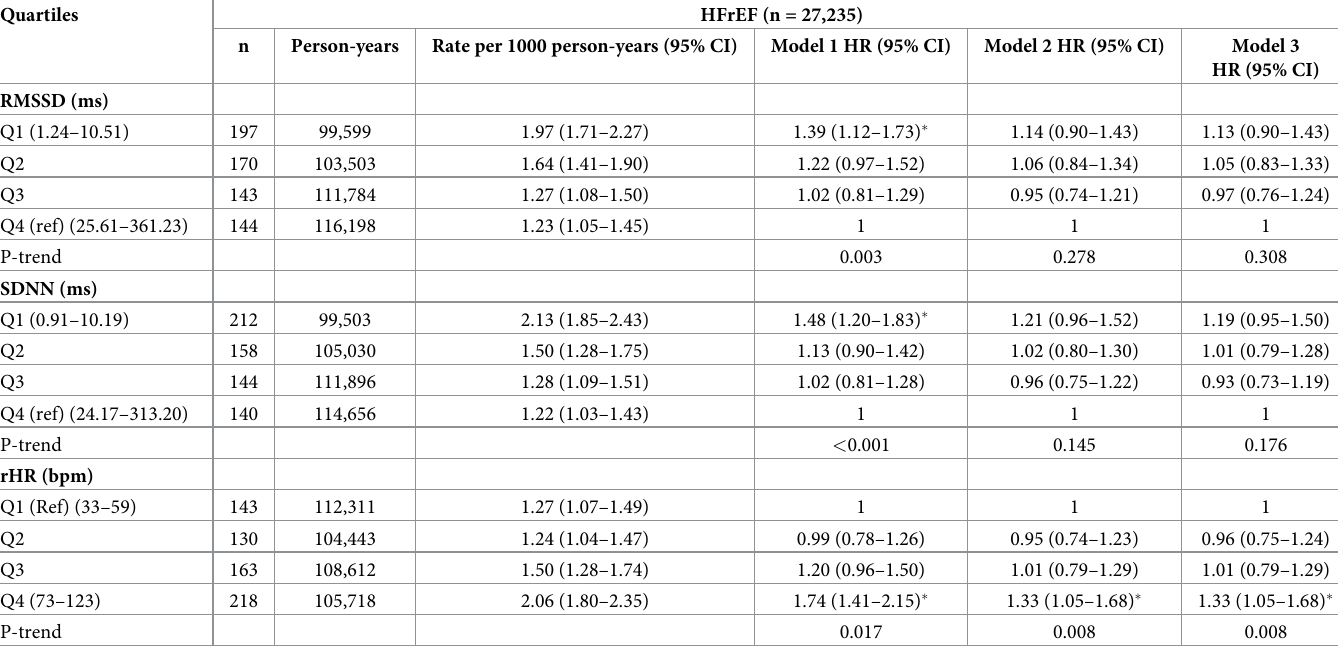
Table 4. Cox proportional hazard ratio with 95% CI of incident hospitalized HFrEF events by quartiles of baseline RMSSD, SDNN and rHR.